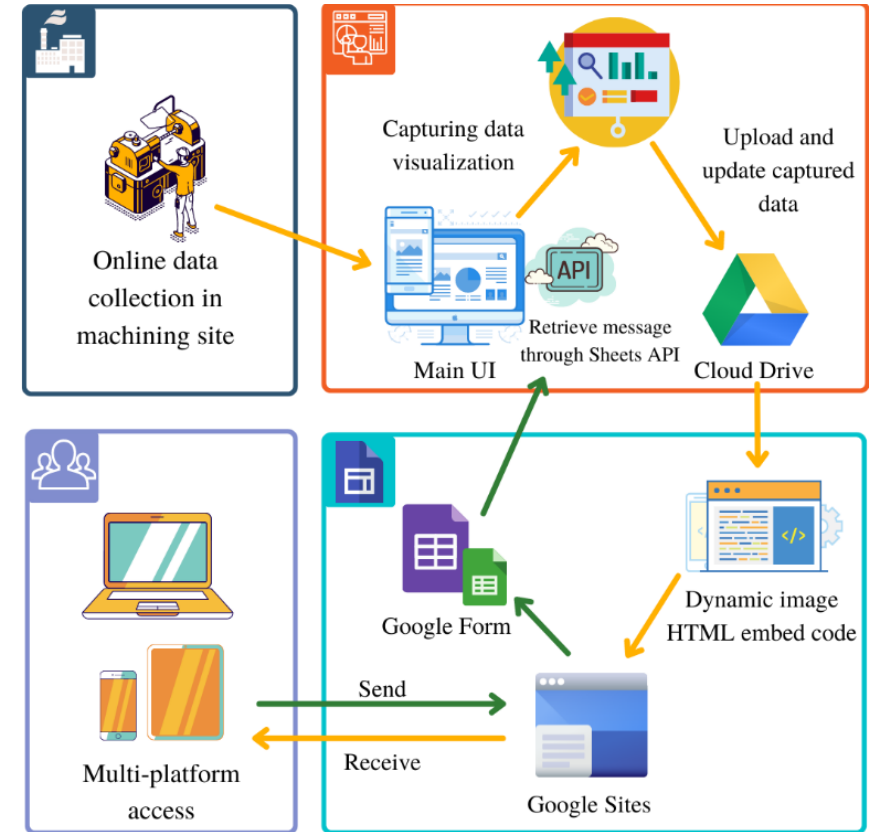
Figure 3. CPMA system